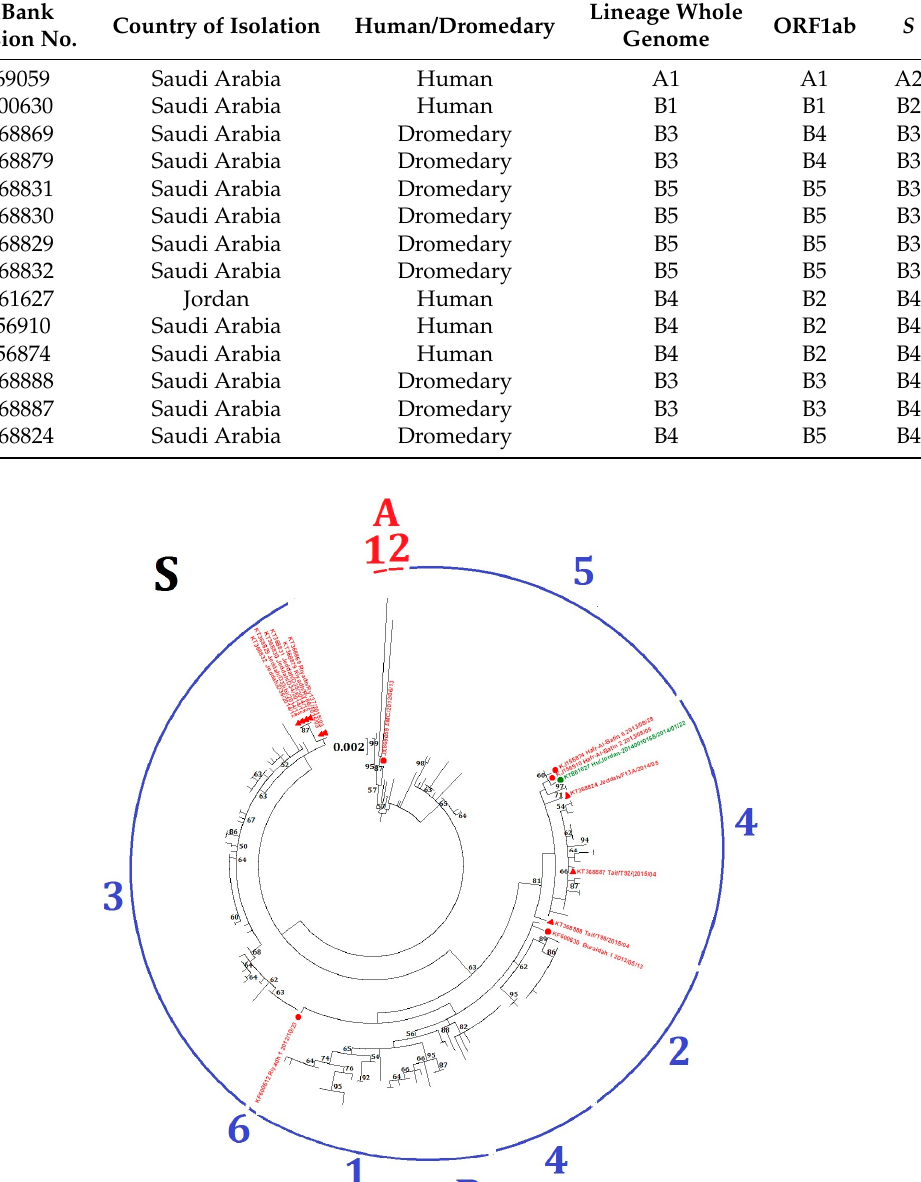
Table 1. MERS-CoV strains that showed differential clustering for ORF1ab and S gene.